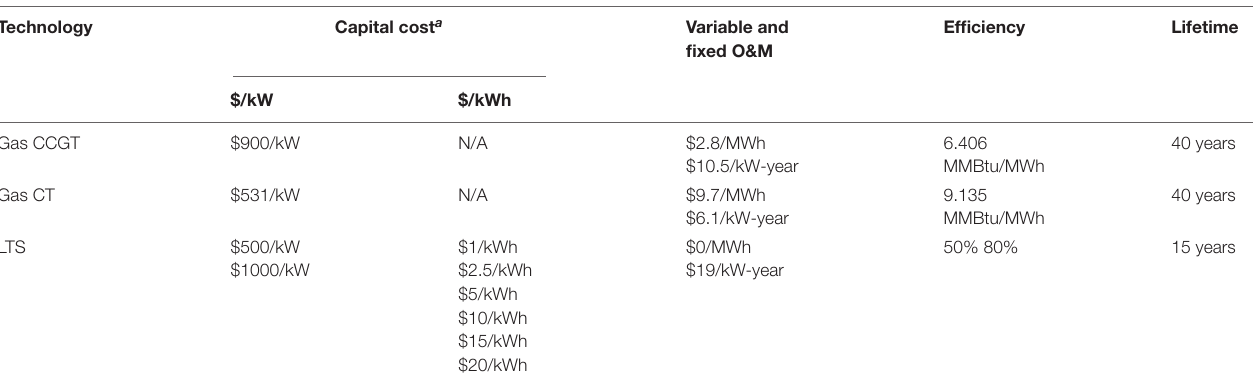
TABLE 2 | Cost assumptions for gas and LTS.